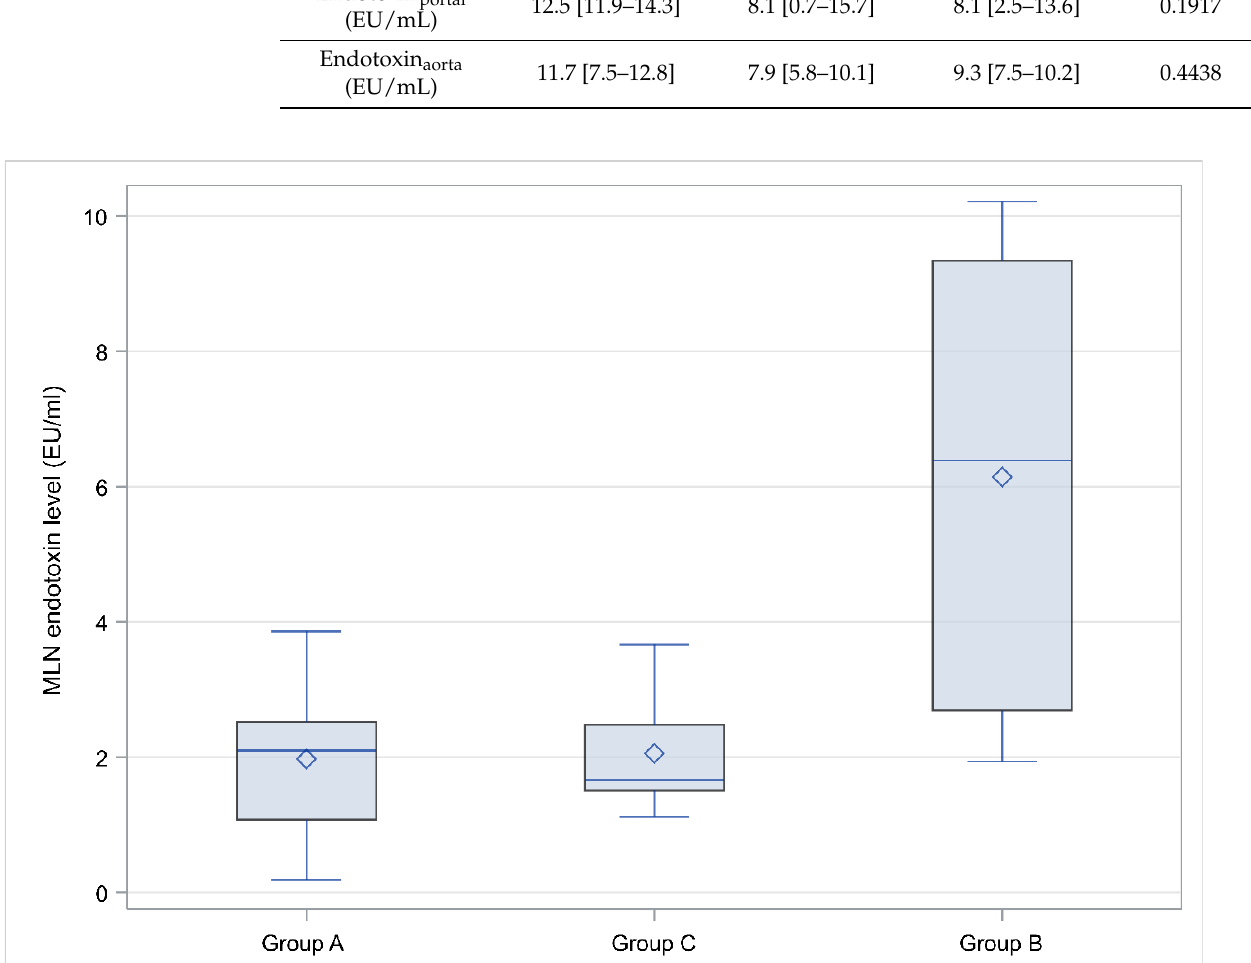
Figure 2. Mesenteric lymph nodes (MLN) endotoxin levels for the three animal groups. Box limits indicate the Q1 and Q3 values, the lines and diamond symbols within the boxes correspond to the median and mean value, respectively, the whisker limits correspond to the minimum and maximum value after outlier exclusion.